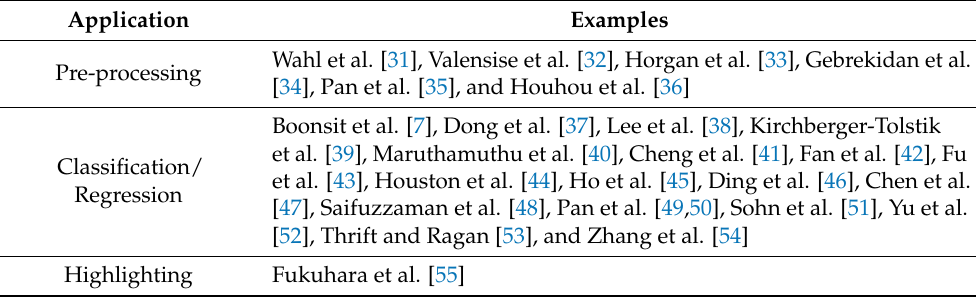
Table 1. Examples of typical deep learning applications for Raman